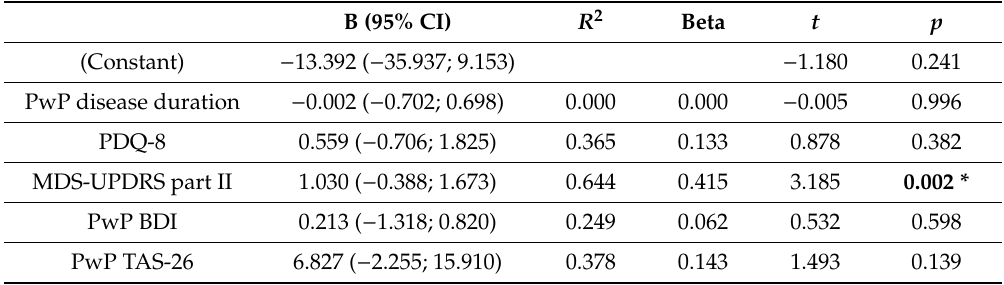
Table 6. Multiple regression analysis of patient factors influencing caregiver burden measured by the disease specific assessment tool PDCB ( n =